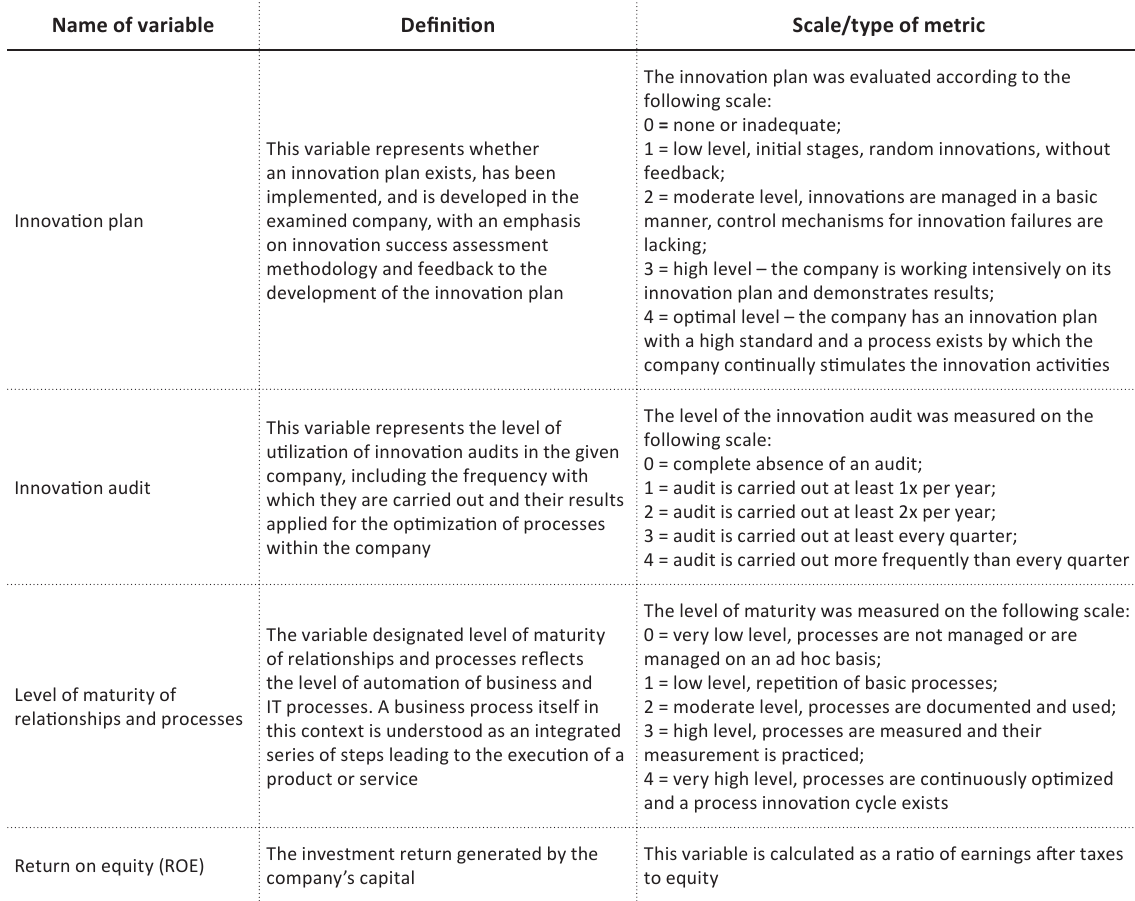
Table 1 (cont.). Description of examined